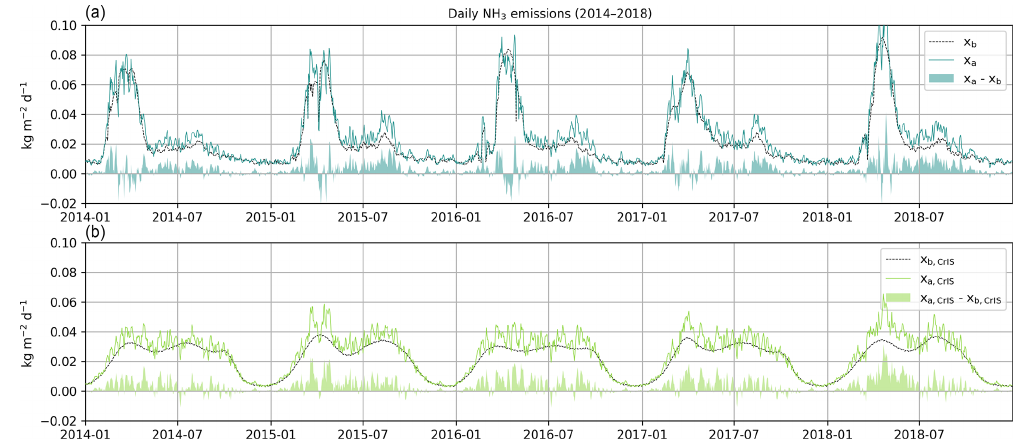
Figure 8. Time series of the daily grid-averaged NH 3 emissions in the background and analysis runs, as well as their absolute difference. Panel (a) (blue) represents the default background ( x b ) and analysis run ( x a ). Panel (b) (green) represents the background ( x b , CrIS ) and analysis run ( x a , CrIS ) with the CrIS-based NH 3 time factors.